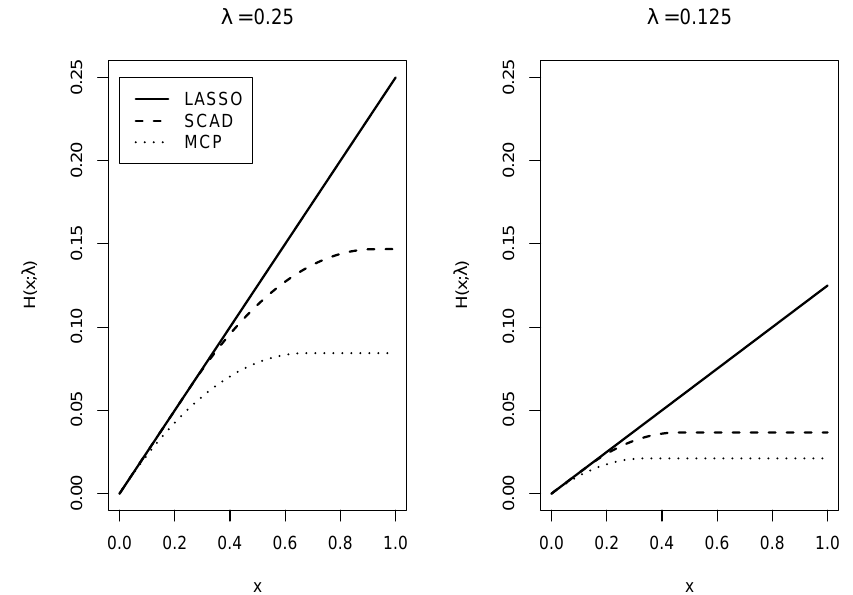
Figure 1. Different penalty functions used in regularization with regularization parameter λ = 0.25 ( left panel ) and λ = 0.125 ( right panel